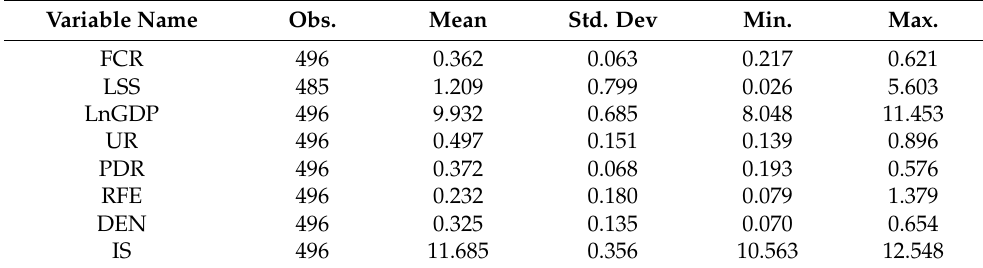
Table 2. Descriptive statistics for the variables